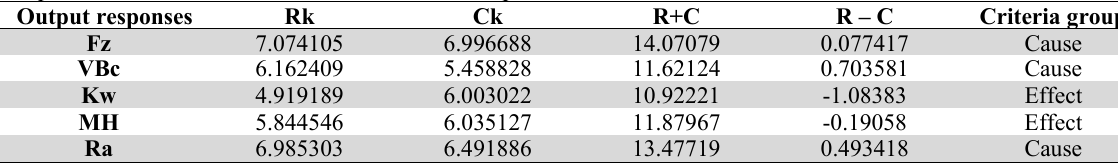
Computation of vectors D and K and net effects of response Out put responses